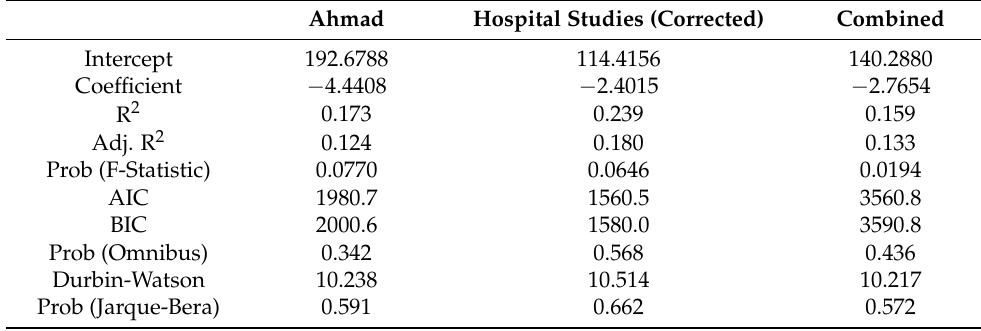
Table 5. OLS regressions for the respective